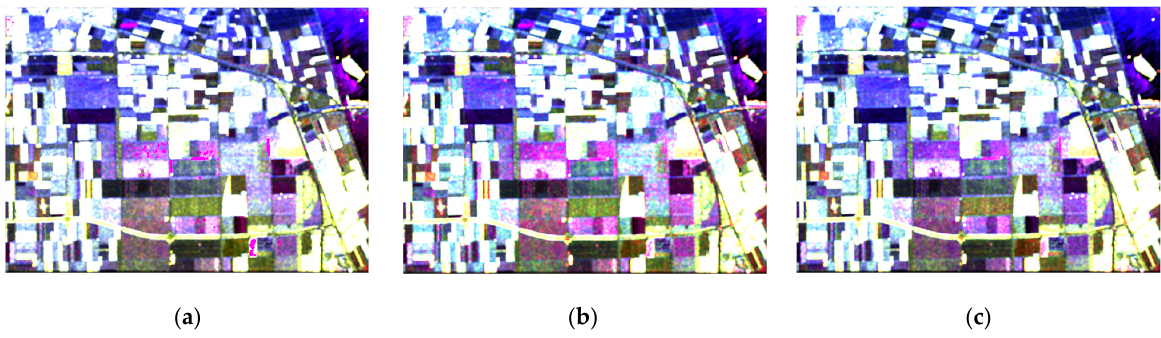
Figure 11. Pseudo-color image of reconstruction result. ( a ) Souyris’ model. ( b ) Nord’s model. ( c ) Proposed model.